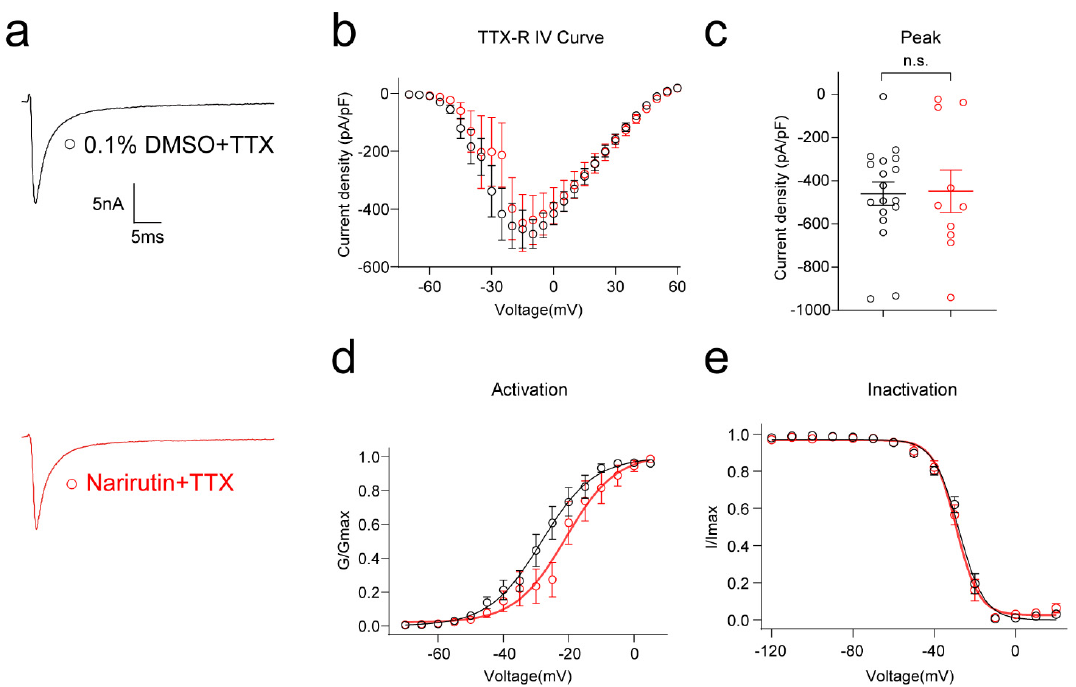
Figure 4. Narirutin did not affect TTX-R currents in DRG sensory neurons. ( a ) Representative traces of the TTX-R currents from DRG sensory neurons treated overnight with 0.1% DMSO + 1 μ M TTX or 20 μ M Narirutin + 1 μ M TTX. Currents were evoked by 200 ms pulse between − 70 and +60 mV. Summary of ( b ) the normalized (pA/pF) sodium current density versus voltage relationship and ( c ) peak TTX-R current density at − 10 mV from DRG neurons treated as indicated. Boltzmann fits for normalized conductance, G/Gmax voltage relationships for voltage-dependent ( d ) activation, and ( e ) inactivation sensory neurons. The half-maximal activation (V 1/2 ) and slope values ( k ) for activation and inactivation are summarized in Table 1. Data are expressed as means ± SEM. ( p > 0.05, Mann–Whitney test, n > 9 cells per